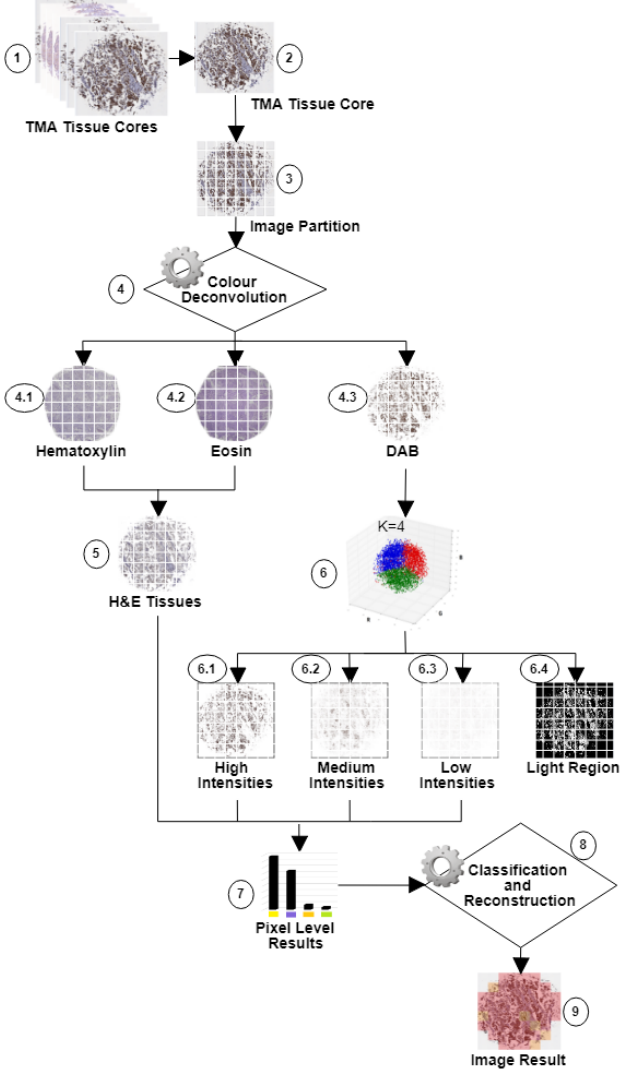
Figure 9. Proposed approach for automated segmentation and quantification of Wnt-1 : (1) TMA tissue core images with DAB (brown), hematoxylin (blue) and eosin (magenta). (2) TMA tissue core image. (3) 64 image blocks. (4) Color Deconvolution process. Color Deconvolution results: (4.1) hematoxylin, (4.2) eosin and (4.3) DAB of the original image. (5) Tissues without DAB. (6) Clustering process with K-means algorithm using initial labels k = 4. (6.1) Wnt-1 high intensities. (6.2) Wnt-1 medium intensities. (6.3) Wnt-1 low intensities. (6.4) Light regions. (7) Quantification results at pixel level. (8) Classification and reconstruction using Allred score. (9) Image result. In the resulting images, the black or color regions correspond to segmented